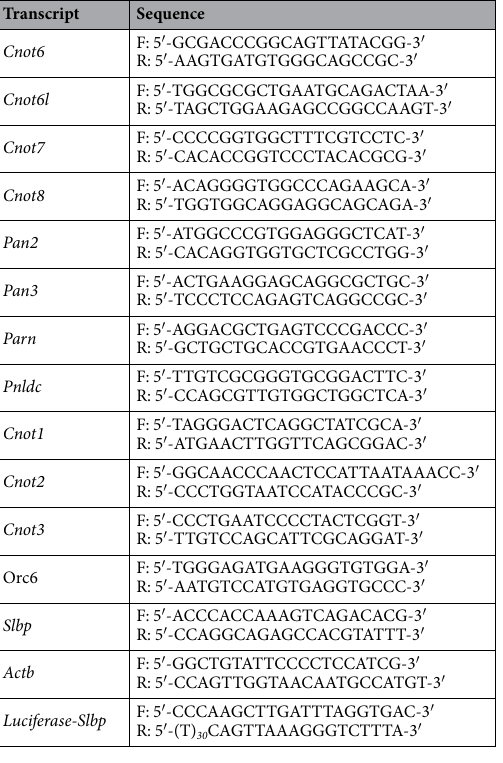
Table 1. PCR primer